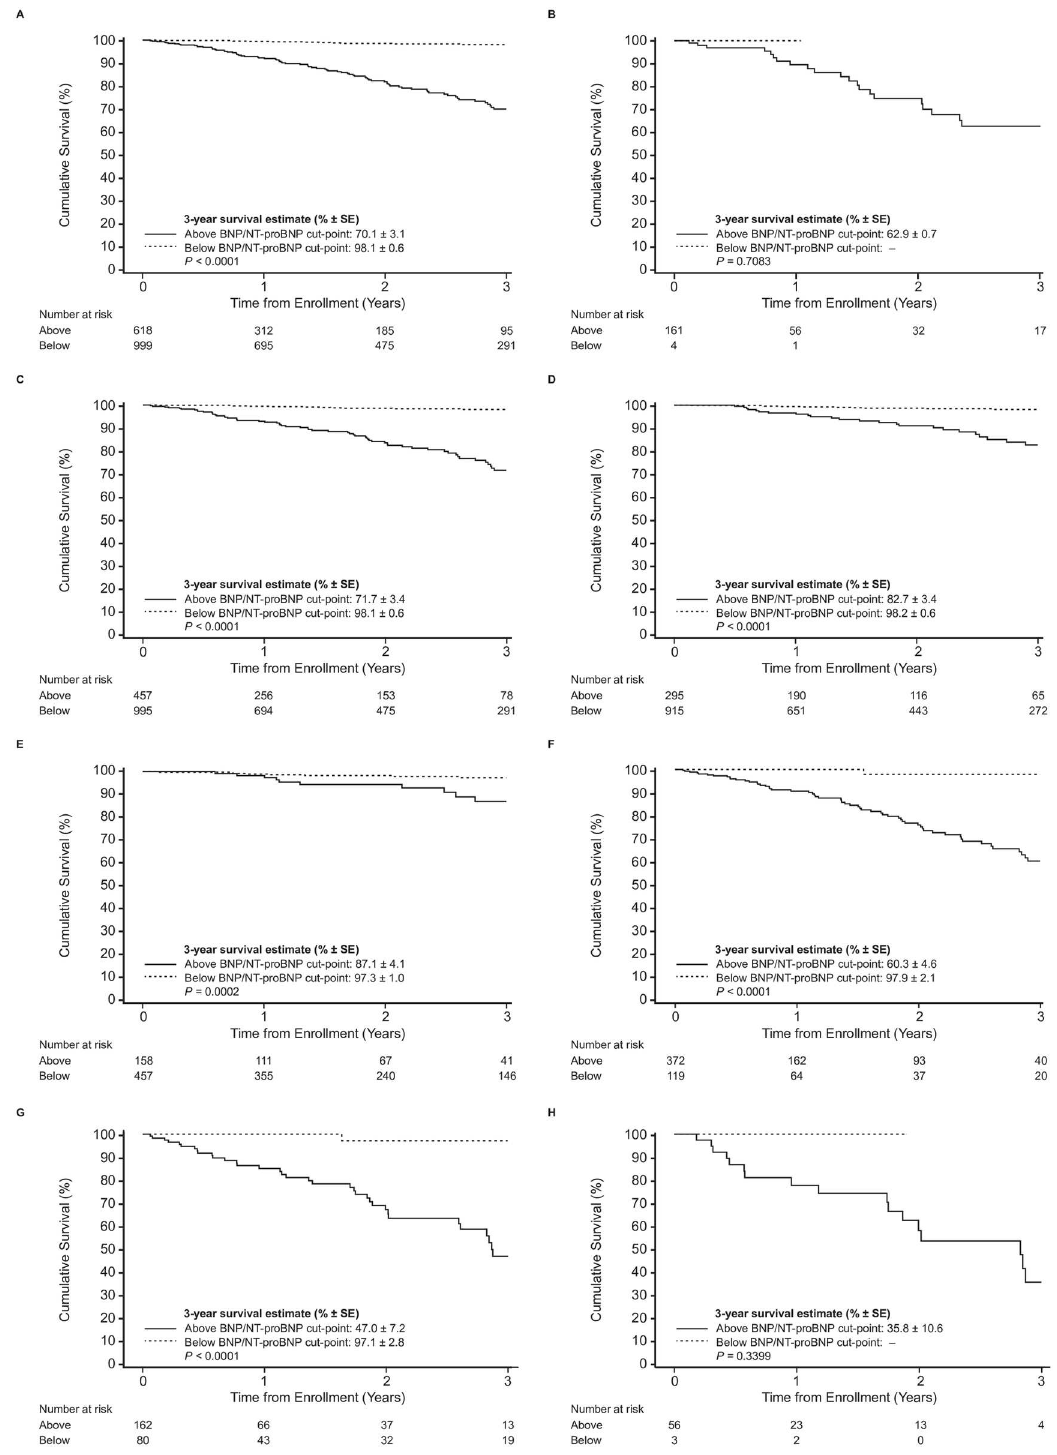
Fig 2. Association of survival and plasma levels of natriuretic peptides in patients with ATTR using unadjusted log-rank test. Survivalstratified by natriuretic peptides(BNP/NT-proBNP) optimalcut-off values (A) in the whole cohort; (B) in patients with wildtypeATTR; (C) in patients with mutant type ATTR; (D) in patients with Val30Met; (E) in patients with early onset of Val30Met; (F) in patients with late onset of Val30Met; (G) in patients with non-Val30Met; (H) in patients with Val122Ile. P -values are for the comparisonbetweenthe combination of abovevs. below the cut-off value.